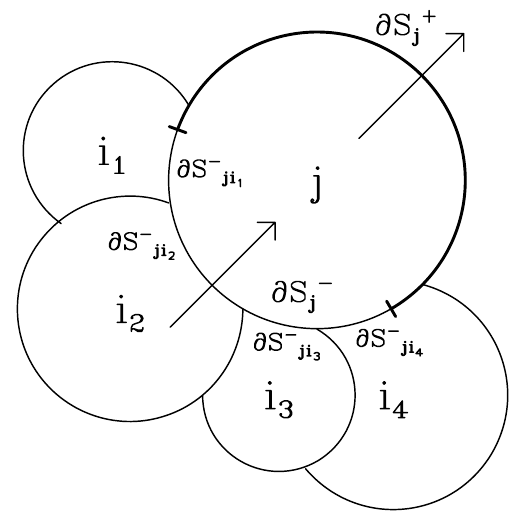
Fig. 2. Schematics for showing the definitions of the boundary seg- ments for the j -th subgrid component. Here, the boundary is first divided into the two parts: those associated with the outflow, ∂S + , j and those associated with the inflow, ∂S − . In the figure, the out- j flow segment, ∂S + , is shown by a thick curve. The inflow segment j is, in the present case, further divided into the four subsegments, ∂S − , ∂S − , ∂S − , and ∂S − , adjacent to the subgrid components, ji 1 ji 2 ji 3 ji 4 i 1 , i 2 , i 3 , i 4 , respectively. Note that this schematics focuses on a sin- gle contour contribution to the j -th component. In general, a j -th component is found everywhere over a grid box with similar subdi- visions to the segment